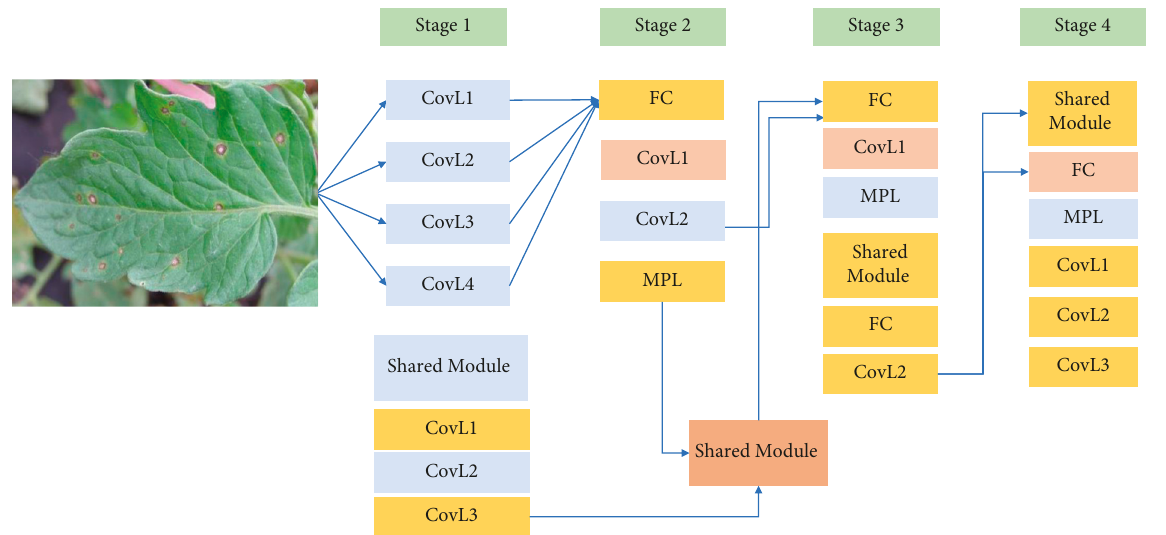
Figure 4: Proposed feature extractor